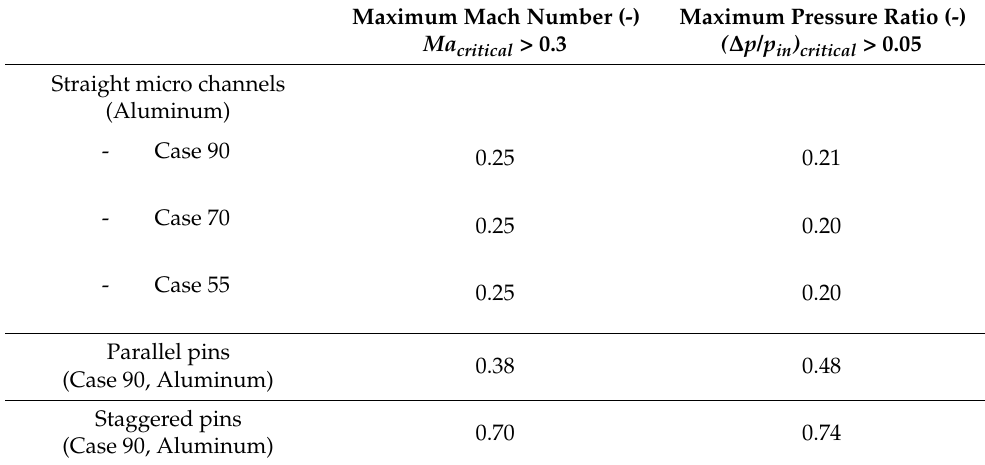
Table 7. Operating conditions for the clamped microstructure heat exchanger examined with air. Maximum Mach Number (-) Maximum Pressure Ratio (-) Ma critical > 0.3 ( ∆ p / p in ) critical >